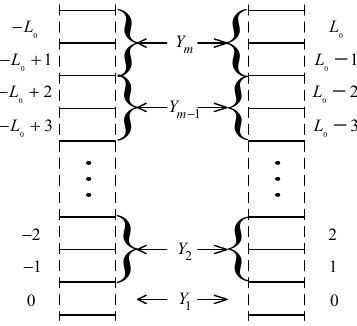
Figure 2. Sub-band distribution.